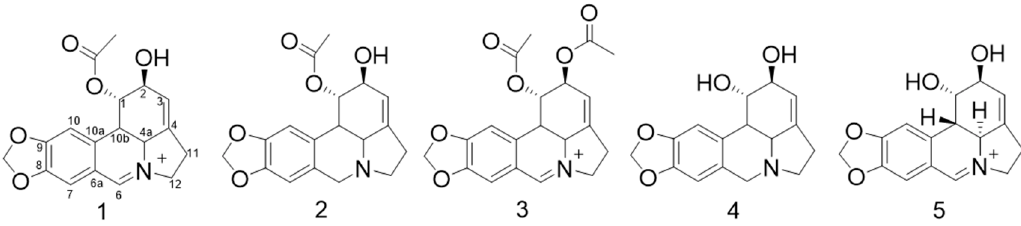
Figure 1. Chemical structure of lycorine-type alkaloids ( 1 , 2 , and 3 ) isolated from Rhodolirium speciosum , lycorine ( 4 ), and 5,6-dehydrolycorine ( 5 ). Table 1. GC-MS analysis of the alkaloids from Rhodolirium speciosum .